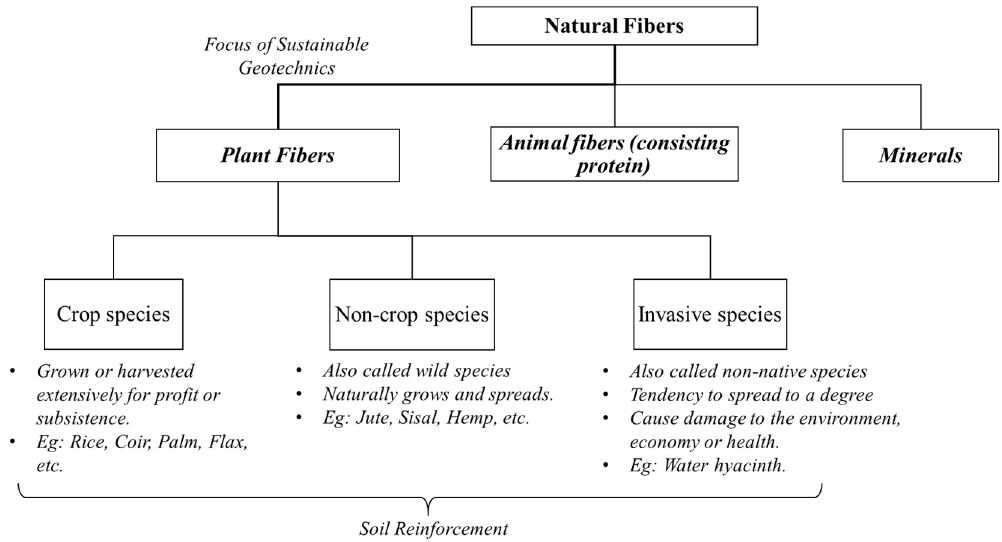
Figure 2. Schematic illustration for categorization of natural fiber incorporated in soil reinforcement.